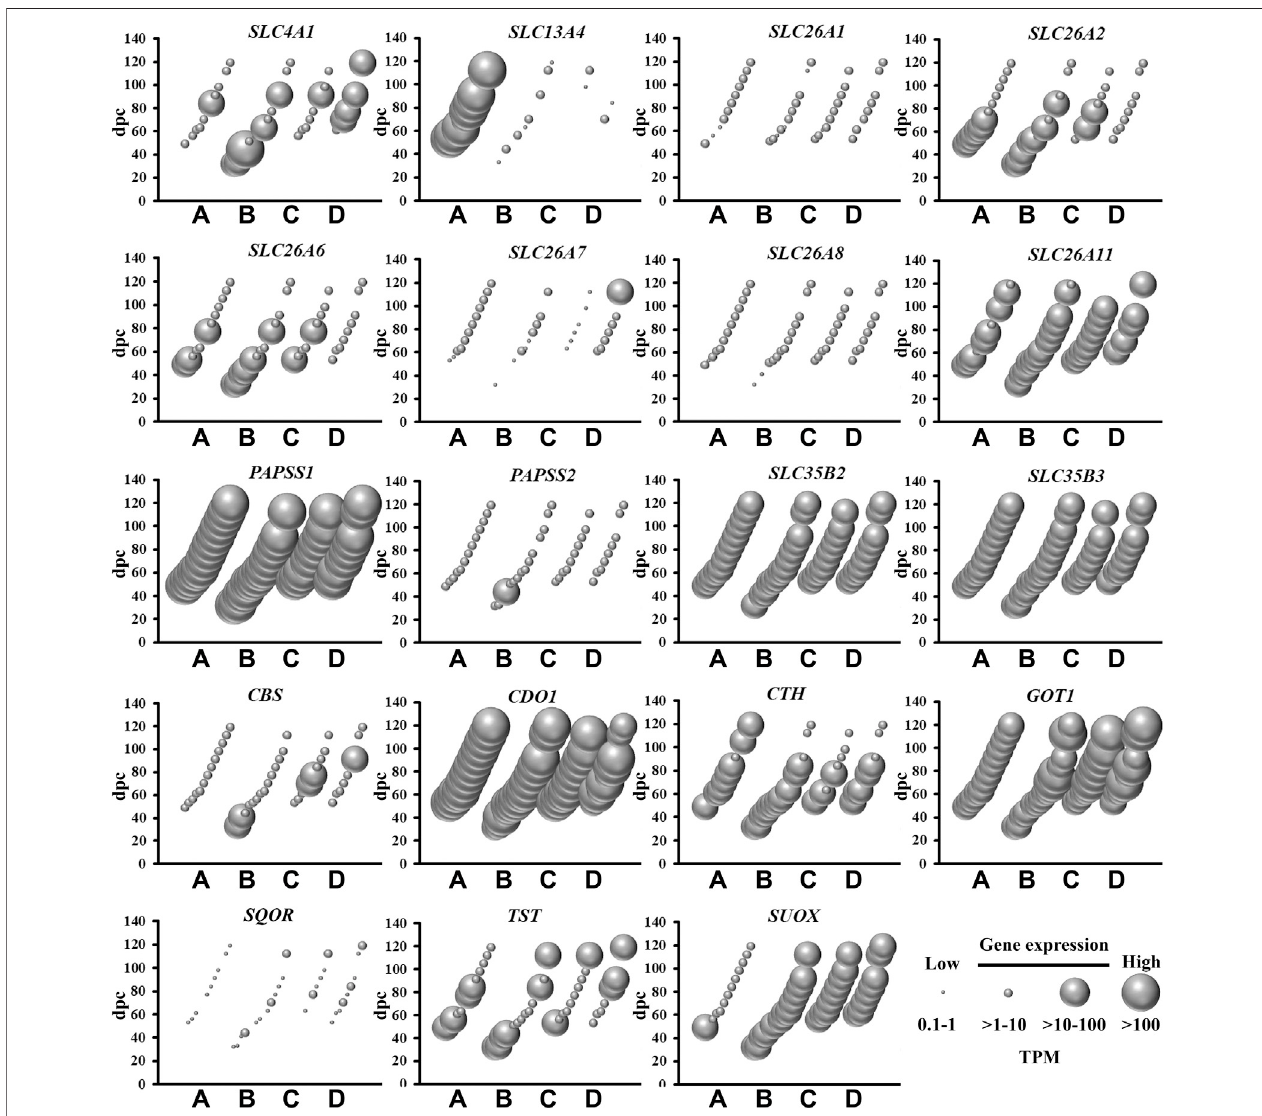
FIGURE1| SpatialandtemporalmRNAexpressionofsulfatetransporters,PAPSsynthetasesandtransporters,andenzymesinthepathwaysofsulfategeneration in fetal brain regions (A) cerebrum, (B) brainstem, (C) diencephalon, and (D) cerebellum. dpc, days post-conception. TPM, transcripts per million.